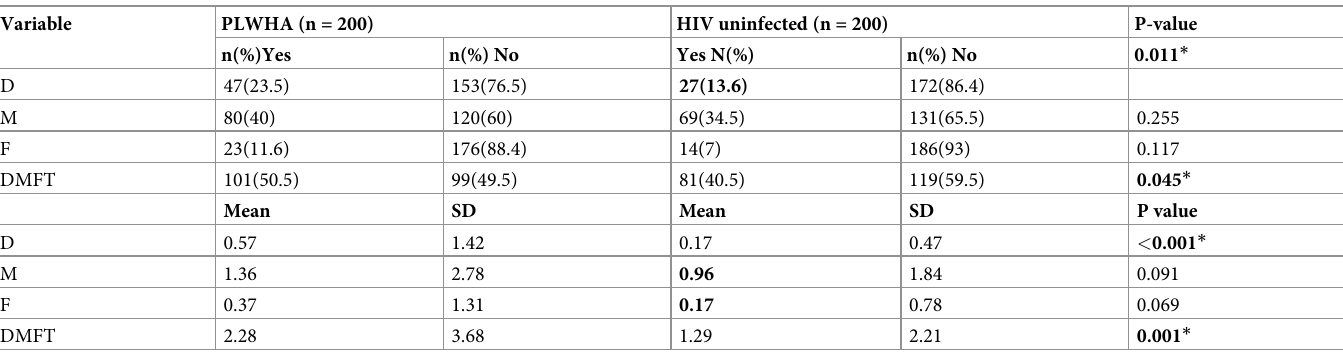
Table 2. Distribution of dental caries according to HIV infection